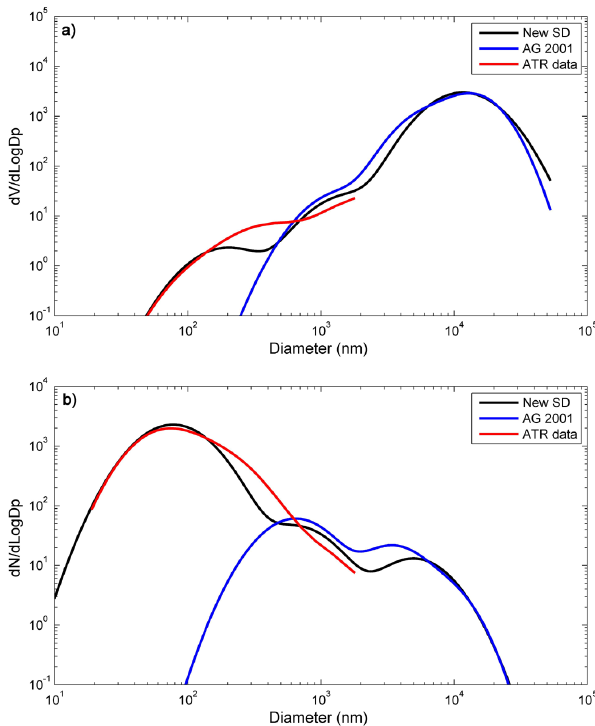
Fig. 2. Volume (a) and Number (b) size distribution of particles given by Alfaro and Gomes (2001) (blue line), by ATR-42 observa- tions (red line) and the new size distribution (black line) proposed in this study and used in the Meso-NH